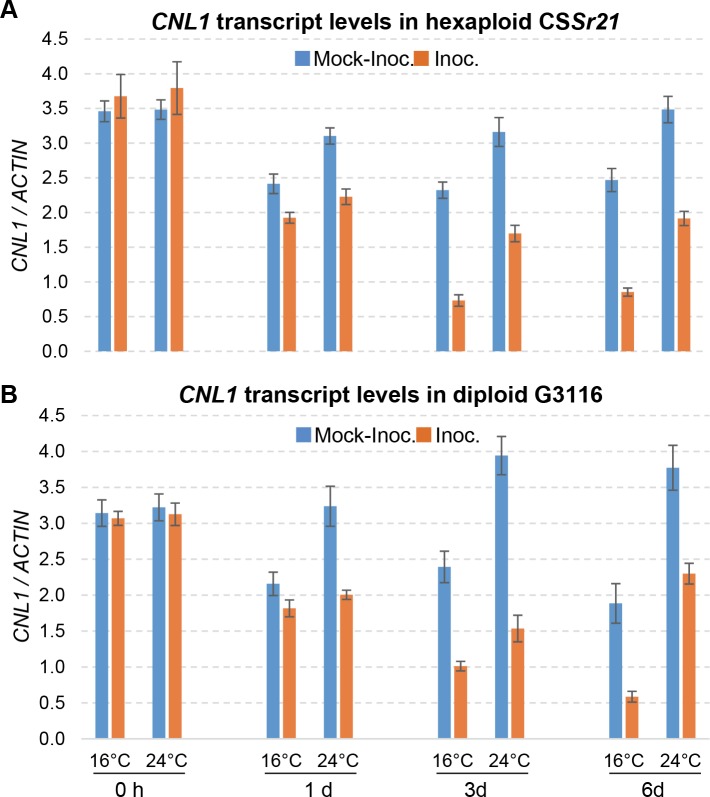
Effect of temperature and Pgt inoculation (race BCCBC) on CNL1 transcript levels.(A)
Sr21 resistant hexaploid wheat CSSr21. (B)
Sr21 resistant diploid wheat G3116. Leaves from both genotypes were collected after inoculation with BCCBC and immediately after moving the plants to chambers at 16°C and 24°C (0 h). The statistical analysis for the 0 h control time point is presented in S4A Table, and the combined analysis for one, three and six days after inoculation in S4B Table. Transcript levels were expressed as fold-ACTIN. Bars are standard errors of the means. Inoc: inoculated with BCCBC, Mock-Inoc: mock inoculated with water.